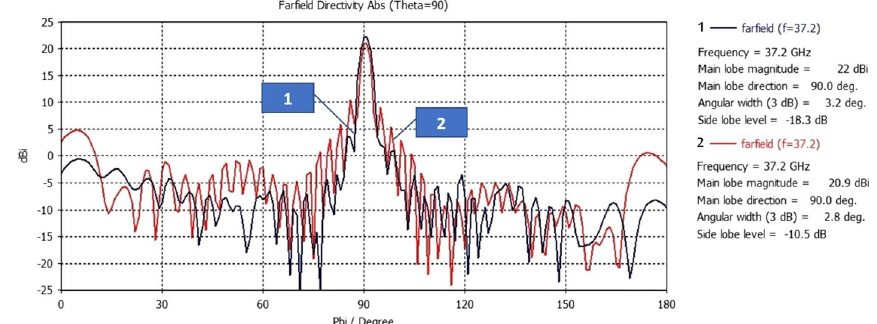
Fig. 13 Comparison of the 1-D calculated radiation pattern at frequency F = 37.2 GHz for antenna with identical and non-identical